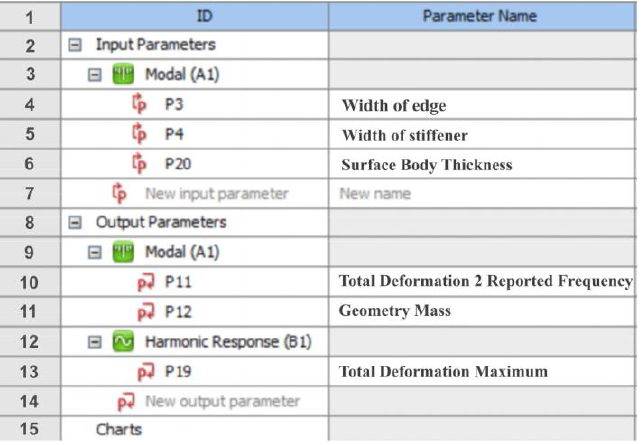
Figure 16. Parametric table.